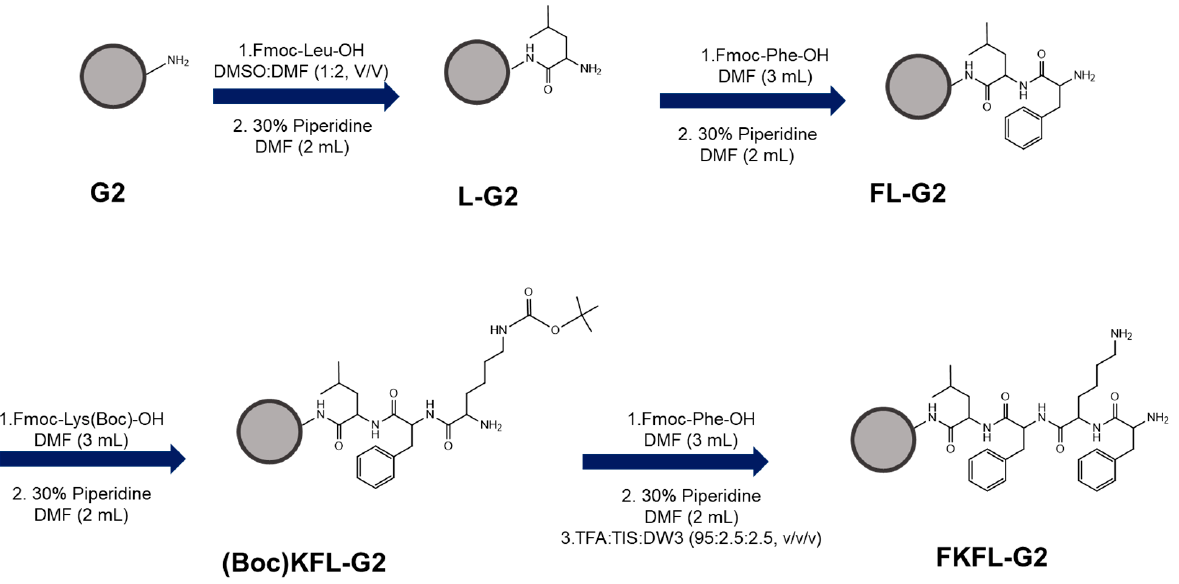
Figure 1. Schematic diagram of the synthesis of phenylalanine (F)-lysine (K)-phenylalanine (F)-Leucine (L)-polyamidoamine generation 2 (PAMAM G2) (FKFL-G2).